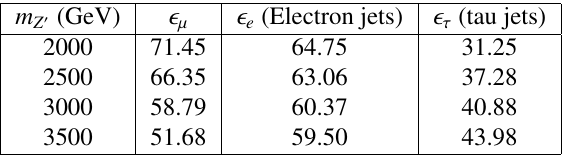
masses. A selectrion (cid:31)